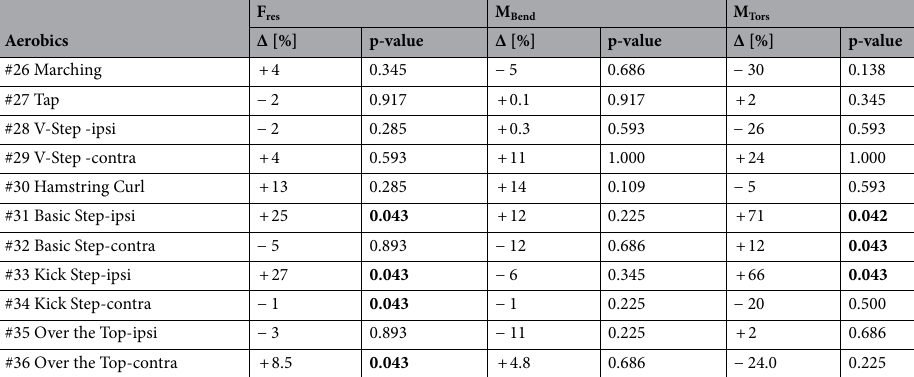
Table 4. Forces and moments of the aerobic exercises. The results are given as delta ∆ (%) of the median peak values of the resultant force F res , bending M Bend and torsion M Tors moment of the aerobic exercises and their variations in relation to the reference activity walking. Ipsi and contra denotes the ipsilateral or contralateral beginning of the movement. Differences between the stretching gymnastic exercises and the reference activity are reported in relation to F res , M Bend and M Tors and Wilcoxon signed rank test was